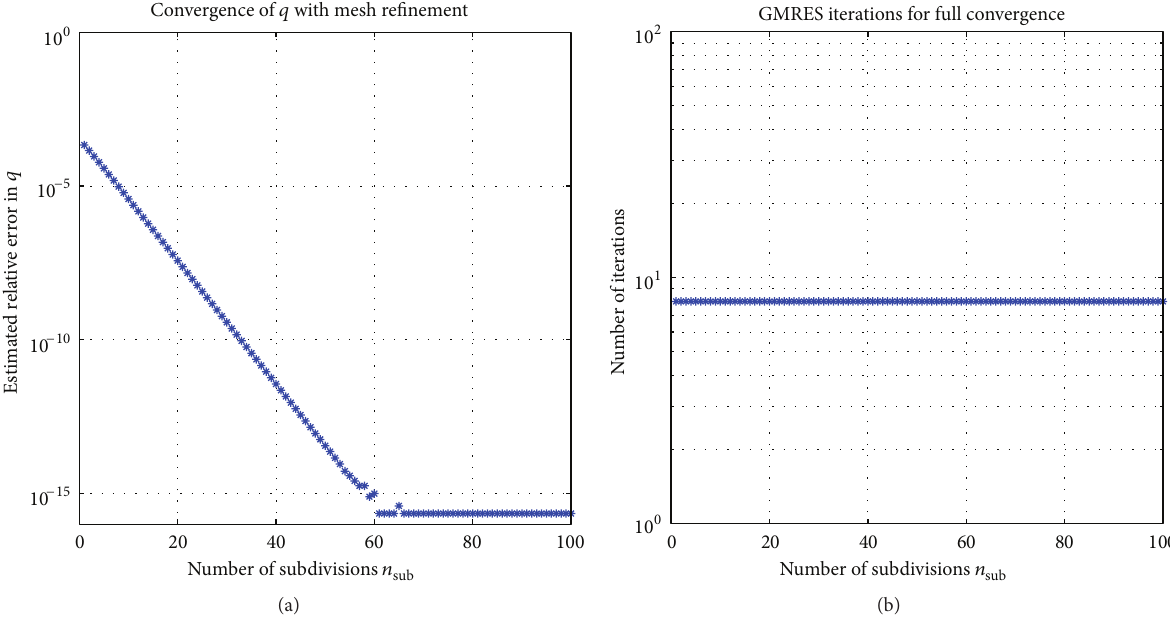
Figure 7: Same as Figure 6, but the program demo3b.m is